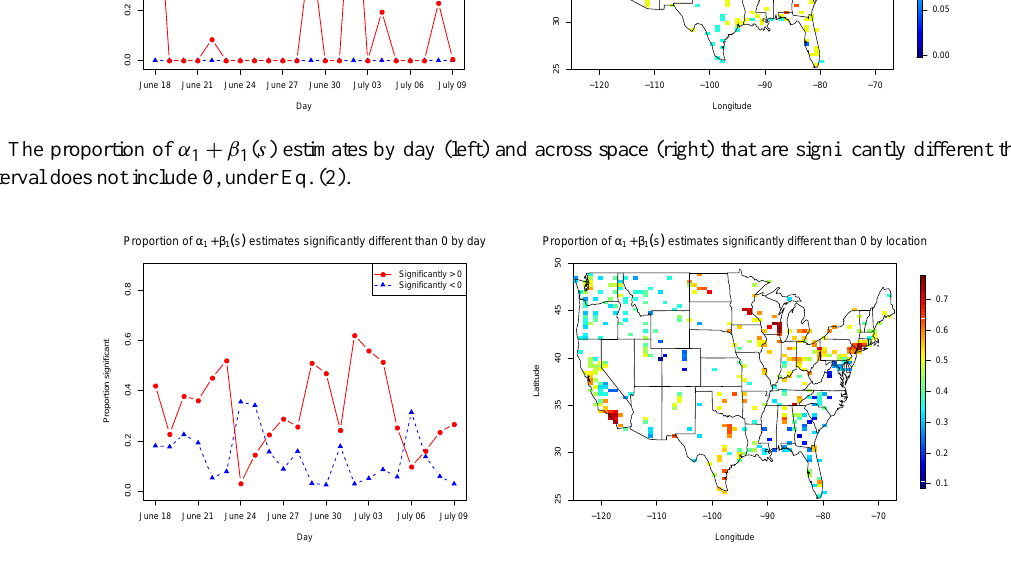
Figure 12. The proportion of α 1 + β 1 ( s ) estimates by day (left) and across space (right) that are significantly different than 0, i.e., 90% credible interval does not include 0, under Eq. (4).